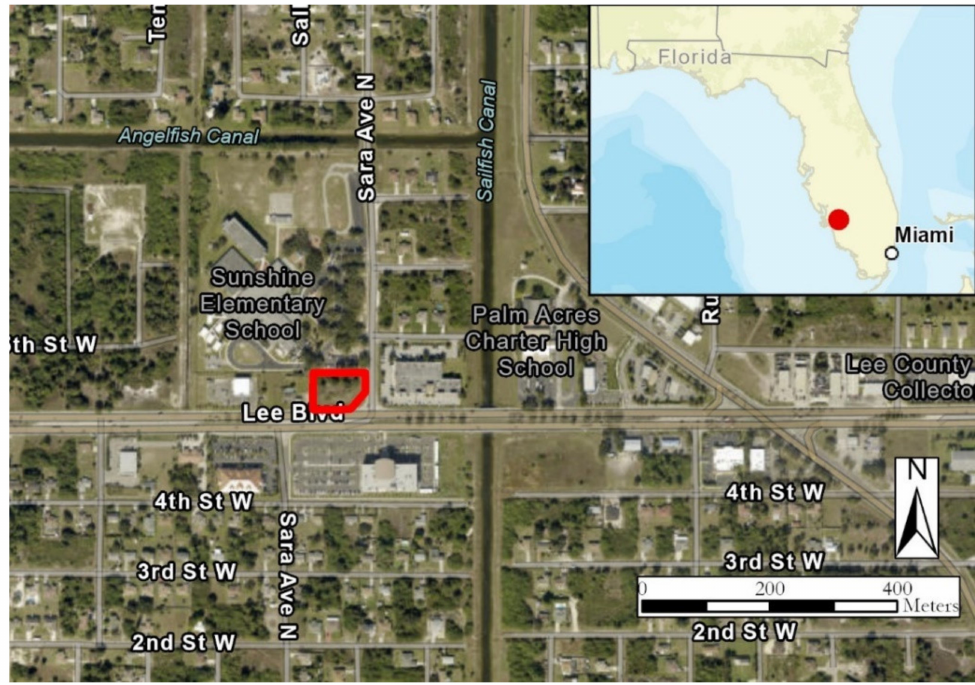
Figure 1. The geographic location of the study area.